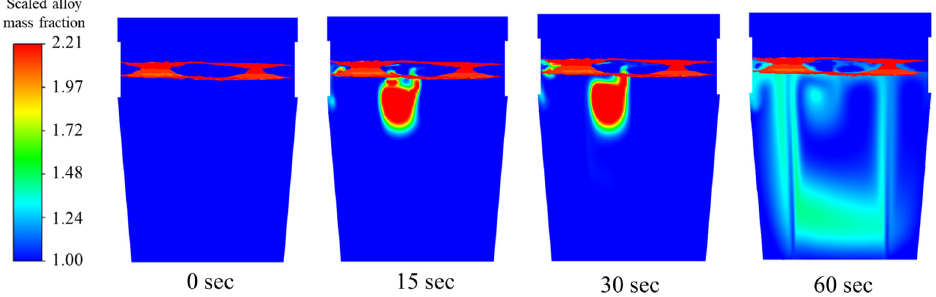
Figure 14. Mixing behavior of copper for 1.13 m 3 /min total flow rate.